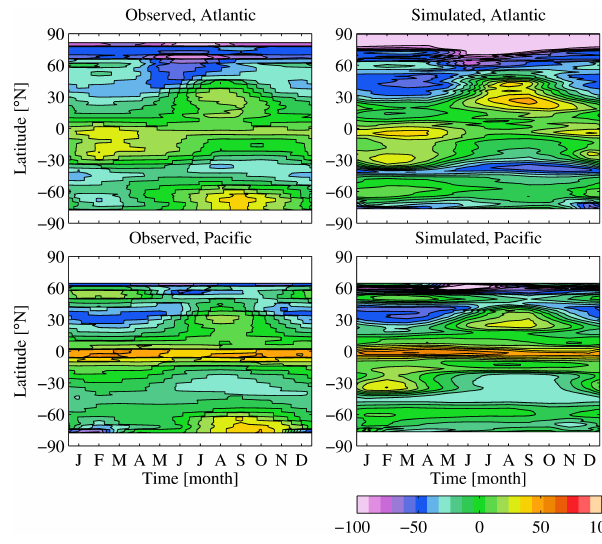
Fig. 21. Observational (Takahashi et al., 2009; left) and simulated (right) surface ∆ p CO 2 for northern summer Fig. 19. Observational (Takahashi et al., 2009; left ) and simulated ( right ) surface ∆ pCO 2 for northern summer (June– July–August; top ) and northern winter (December–January–February; bottom ). ∆ pCO 2 in ppm.